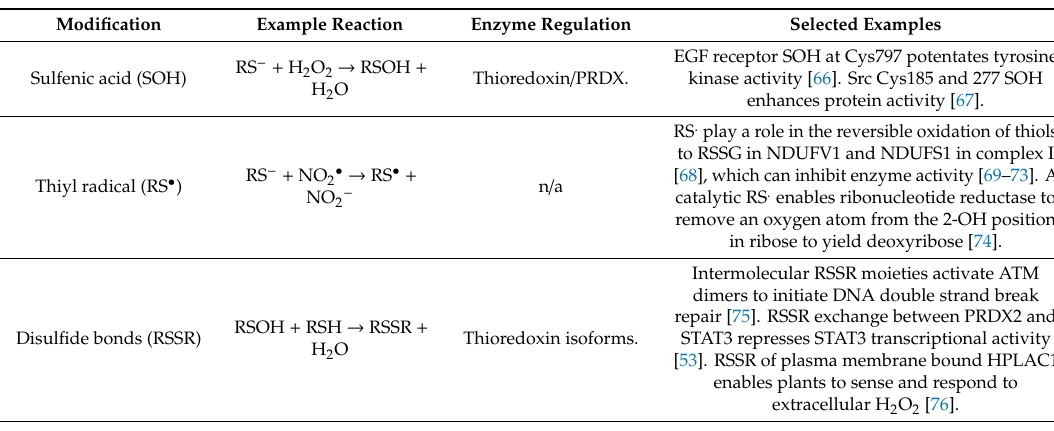
Table 1. Major reversible thiol modifications by type. Key reactions and enzyme regulated, and selected examples are provided. Note many more important modifications (e.g., S -acetylation [65]) exist. The table merely provides a brief overview of some of the key